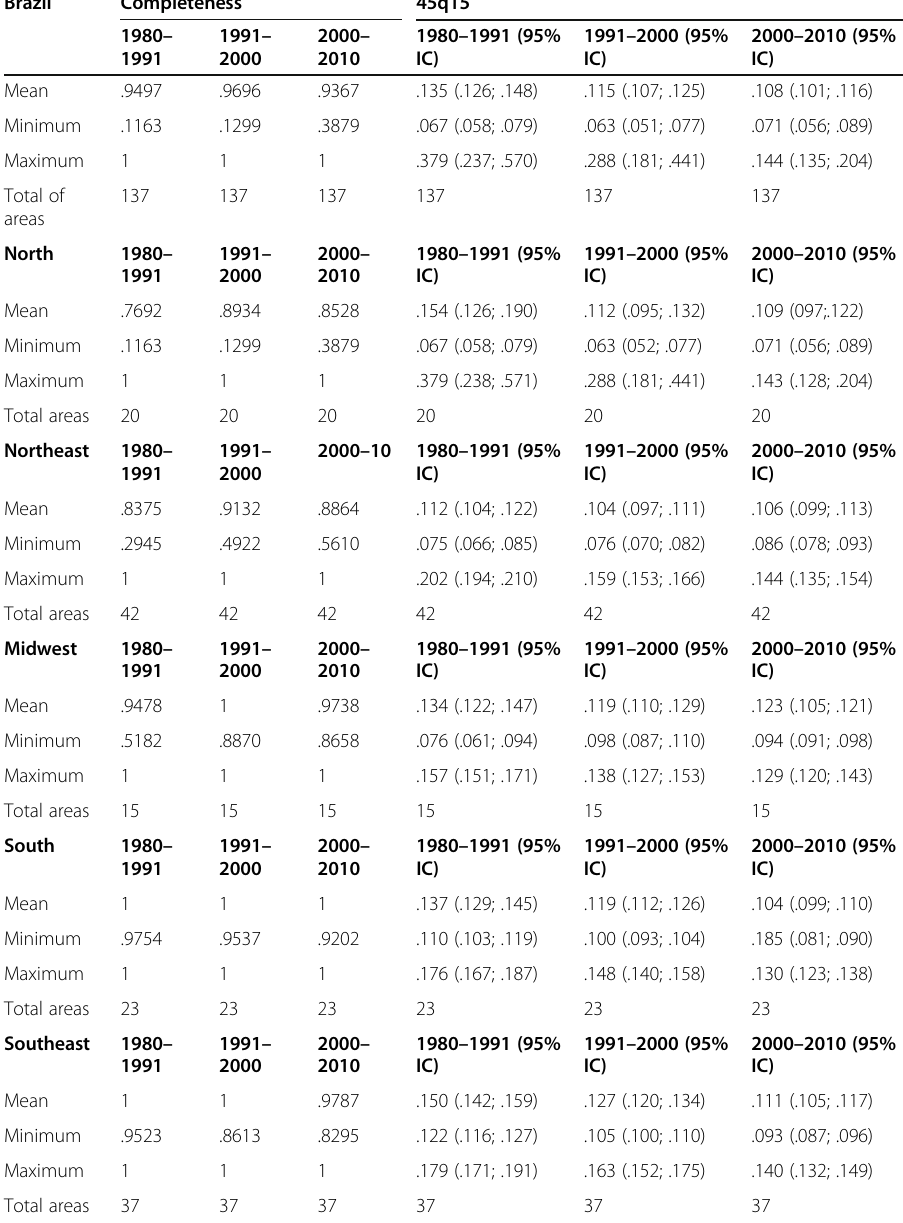
Table 1 Completeness of Death Counts and Adult Mortality Rates for Females: Brazil and regions, 1980 –